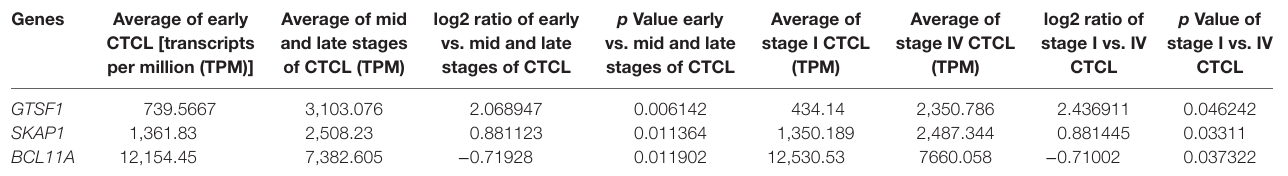
TaBle 4 | Genes with statistically significant differences in expression both between ≥ 2009 early stage ( ≤ IIA) vs. mid and late stage ( ≥ IIB) formalin-fixed paraffin- embedded (FFPE) cutaneous T-cell lymphoma (CTCL) samples (left panel) and between ≥ 2009 stage I vs. stage IV FFPE CTCL samples (right